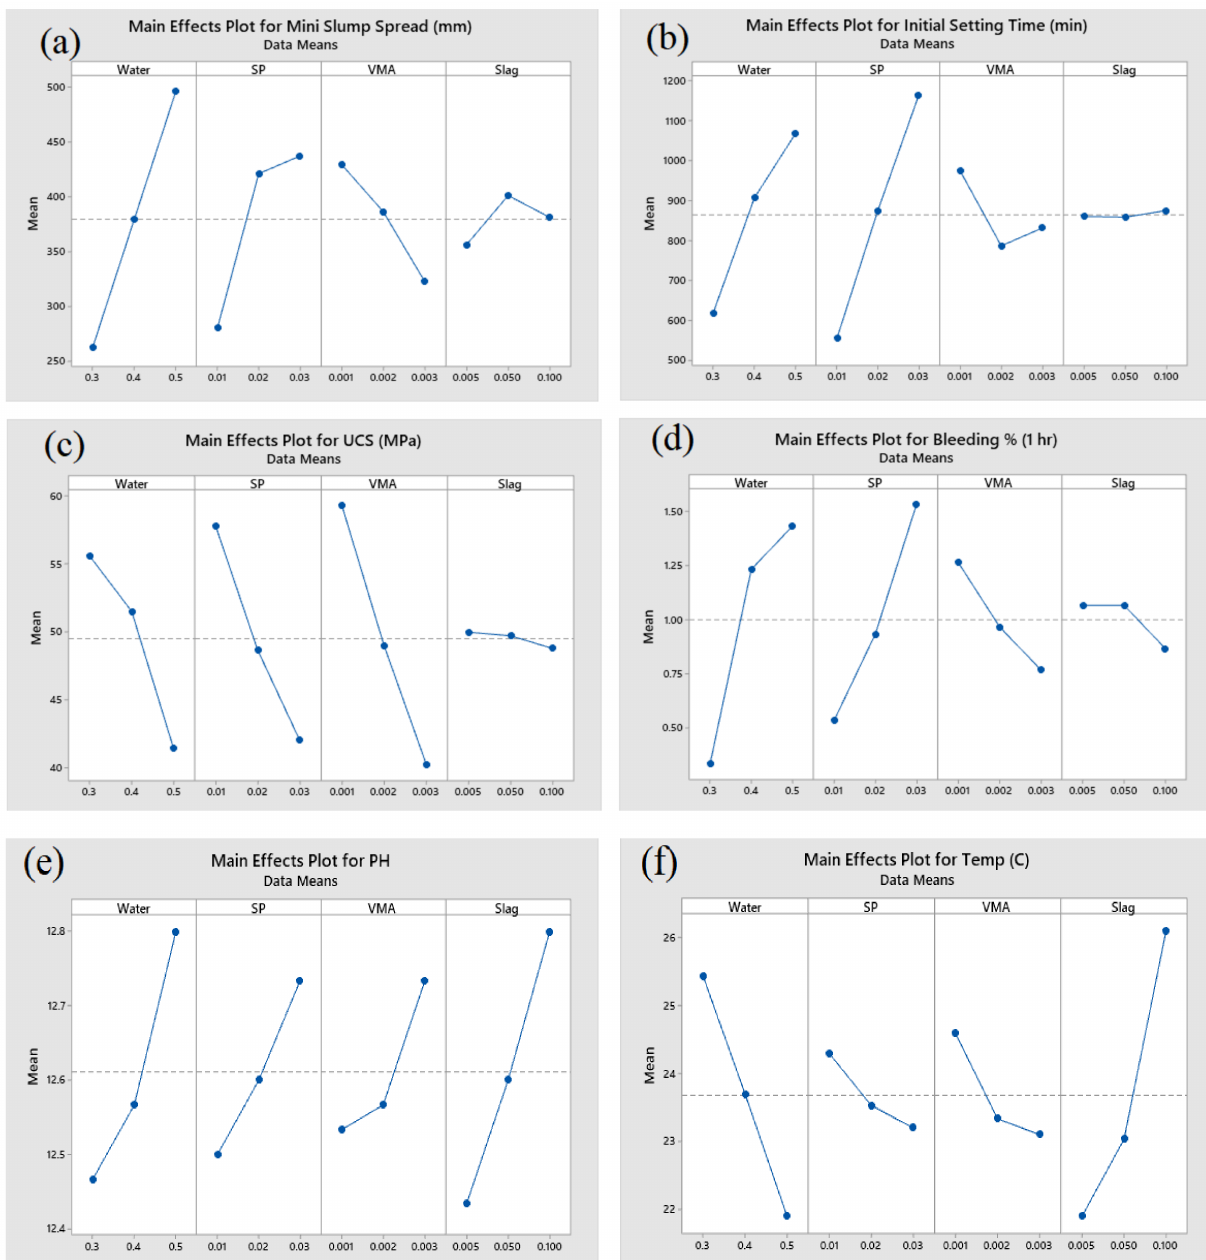
Figure 17. Main effect of plots for ( a ) mini slump spread, ( b ) initial setting time, ( c ) UCS of cubes (MPa), ( d ) bleeding %, ( e ) pH, and ( f )